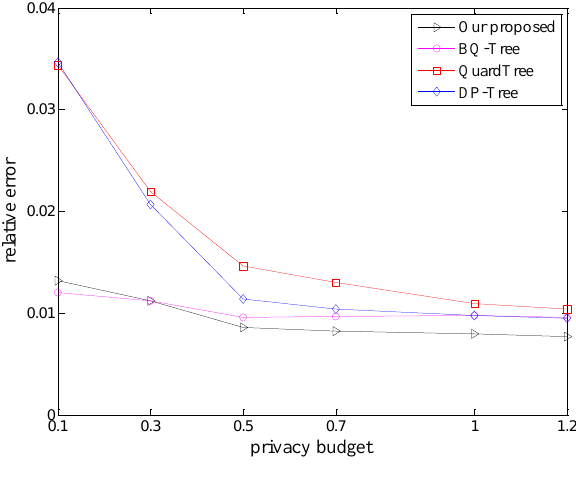
Figure 5. Query range Q = 1%.